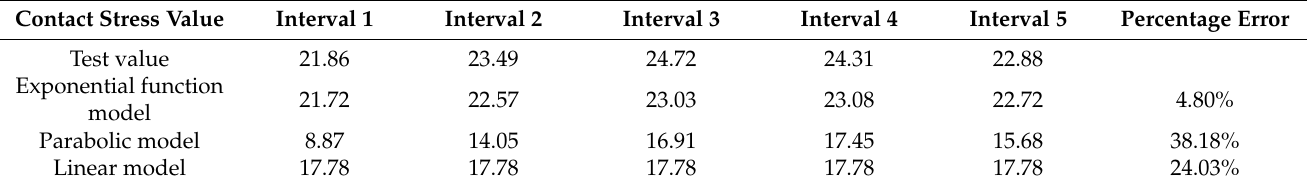
Table 6. Error comparison between different models and experimental stress values (N/cm 2 ) ( λ =